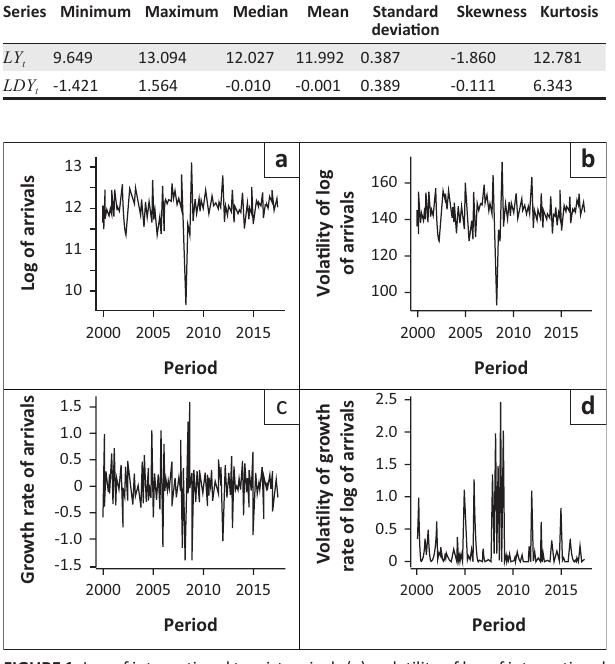
FIGURE 1: Log of international tourist arrivals (a), volatility of log of international tourist arrivals (b) growth rate of international tourist arrivals (c) and volatility of growth rate of international tourist arrivals (d).